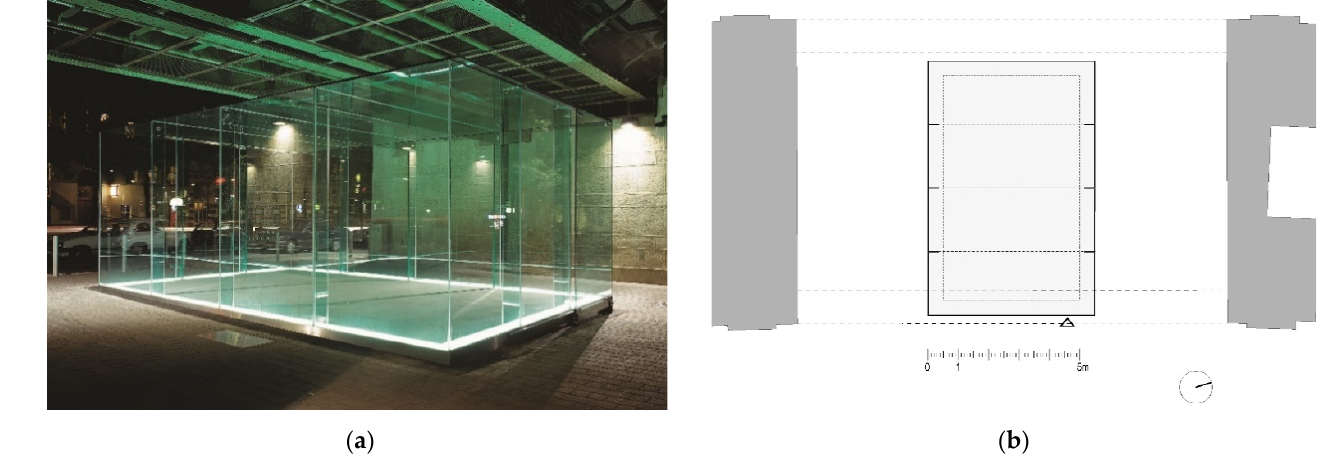
Figure 13. Export Pavilion in Wien: ( a ) view of the pavilion (© Rupert Steiner); ( b ) floor plan of the pavilion (© Architects Tillner & Willinger).